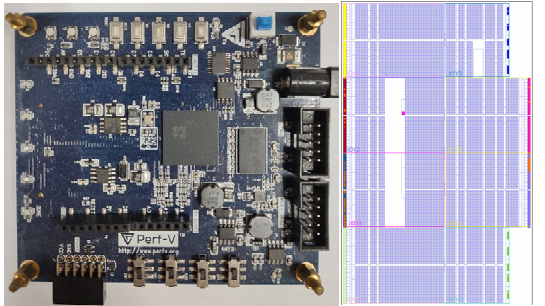
Figure 10. Experimental environment and diagram of the circuit layout.